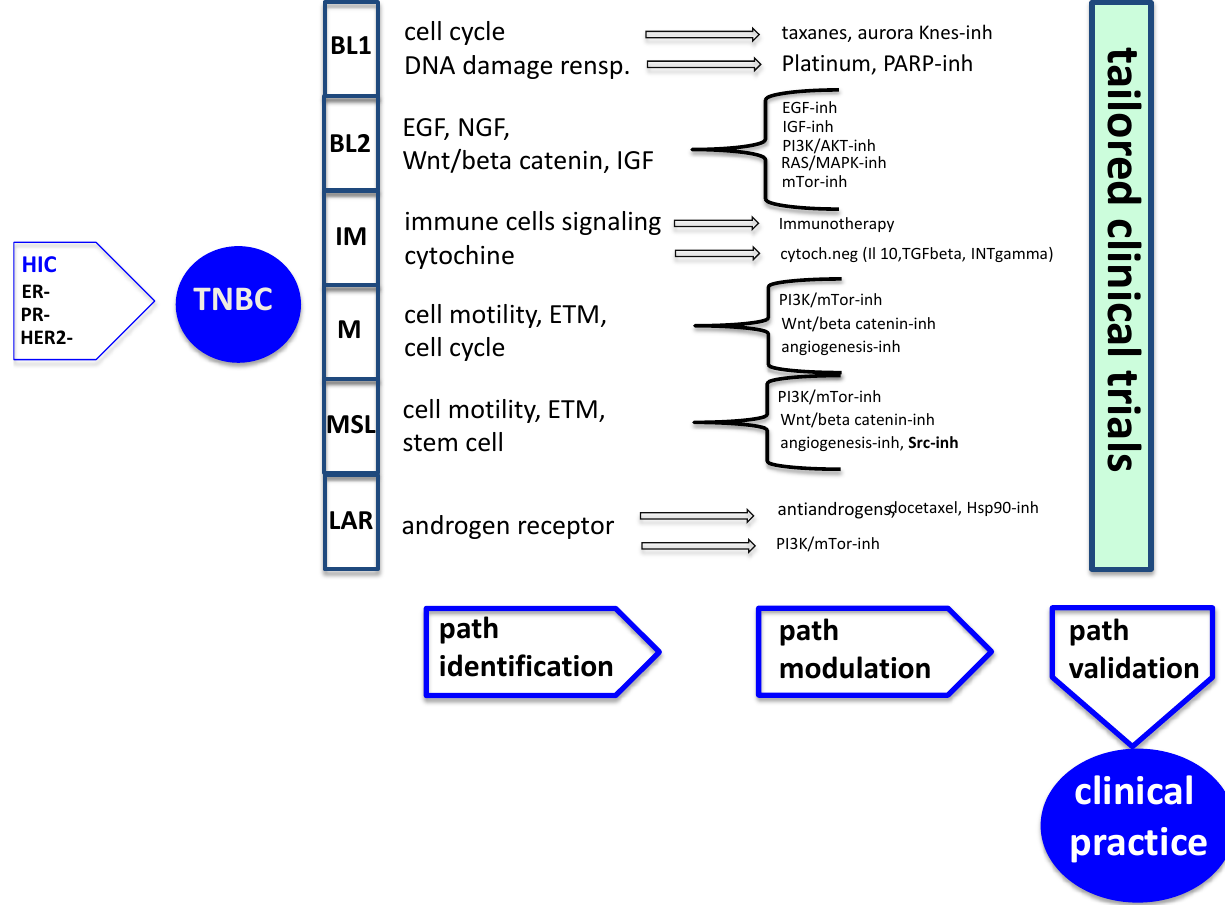
Figure 1. Optimize therapeutic strategies in metastatic TNBC. Schematic representation of the steps which are needed for a rational treatment of each subtype. The paths must be identified, modulated, and finally validate from small taloired clinical trials, in order to approve their acceptance in clinical